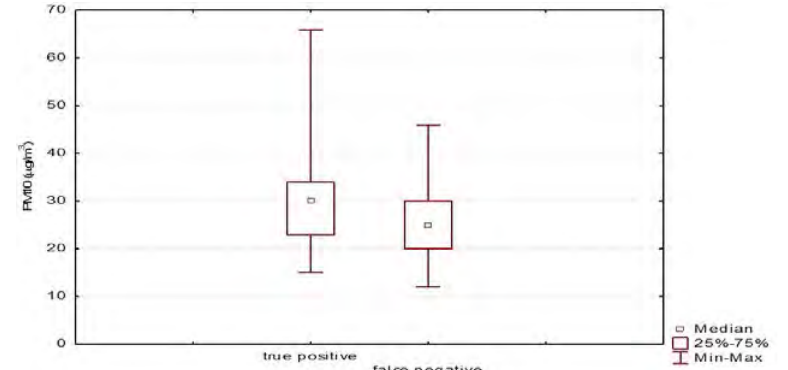
Fig. 8: PM10 distribution during false positive and true positive